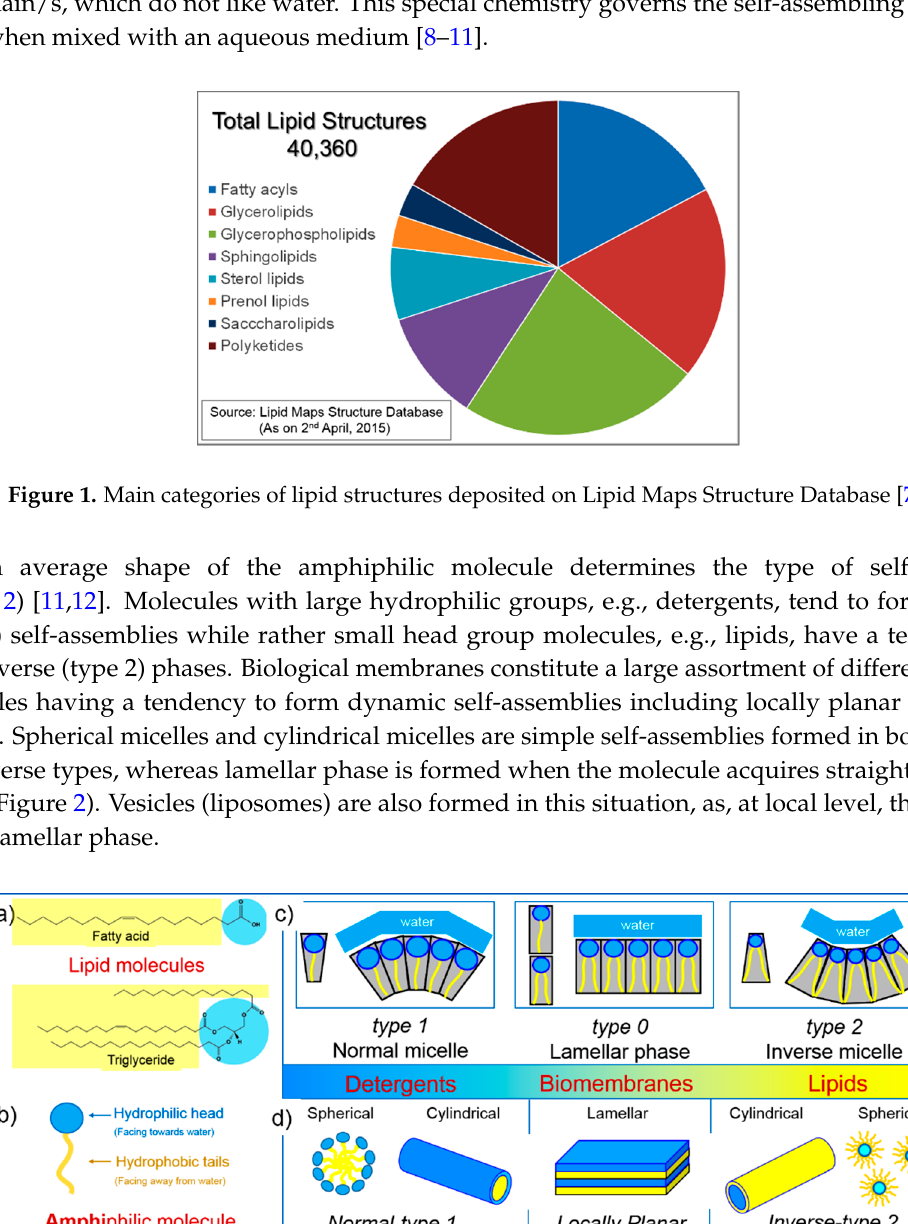
Figure 2. ( a ) Chemical structures of typical lipid molecules; ( b ) Schematic diagram of an amphiphilic molecule where blue and yellow colors roughly code for hydrophilic and hydrophobic parts of the molecule; ( c ) Average molecular shapes and process of self-assembling of amphiphilic molecules when they are mixed with water; ( d ) Schematics of simple self-assemblies formed by amphiphilic molecules.